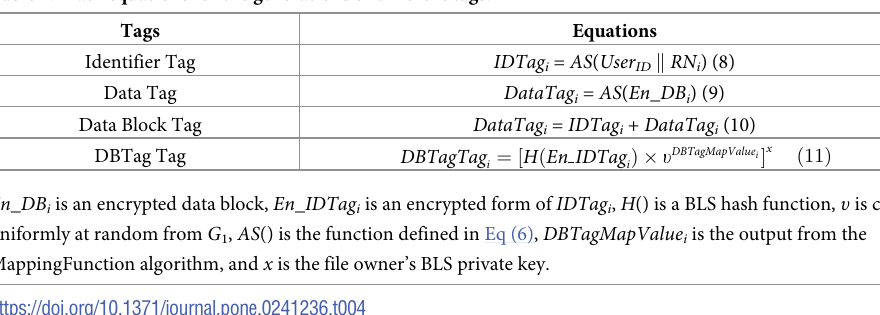
Table 4. Math equations for the generations of different